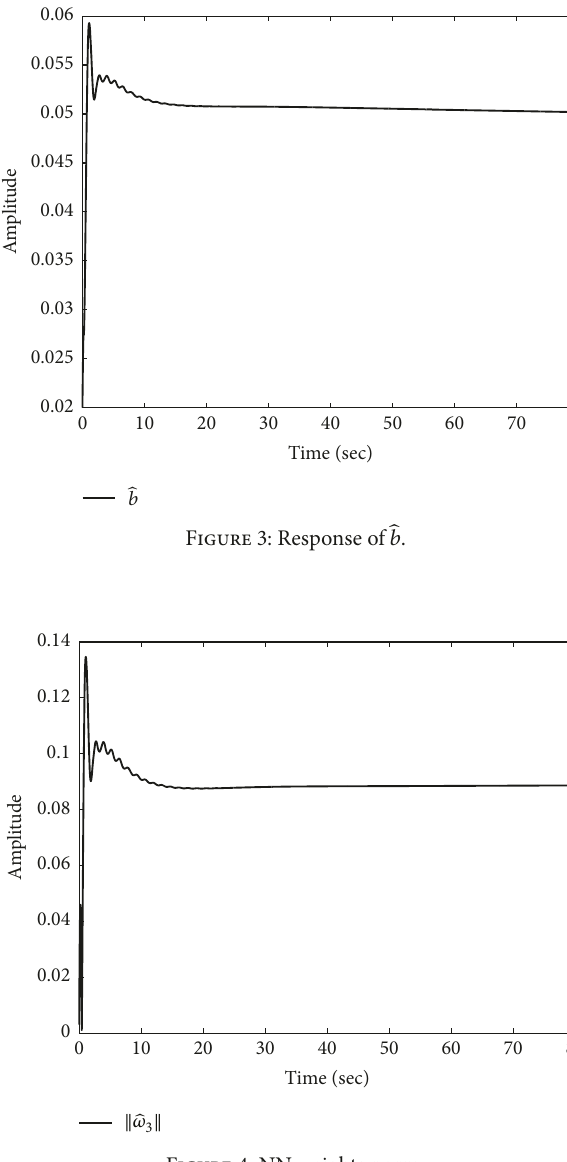
Figure 4: NN weights